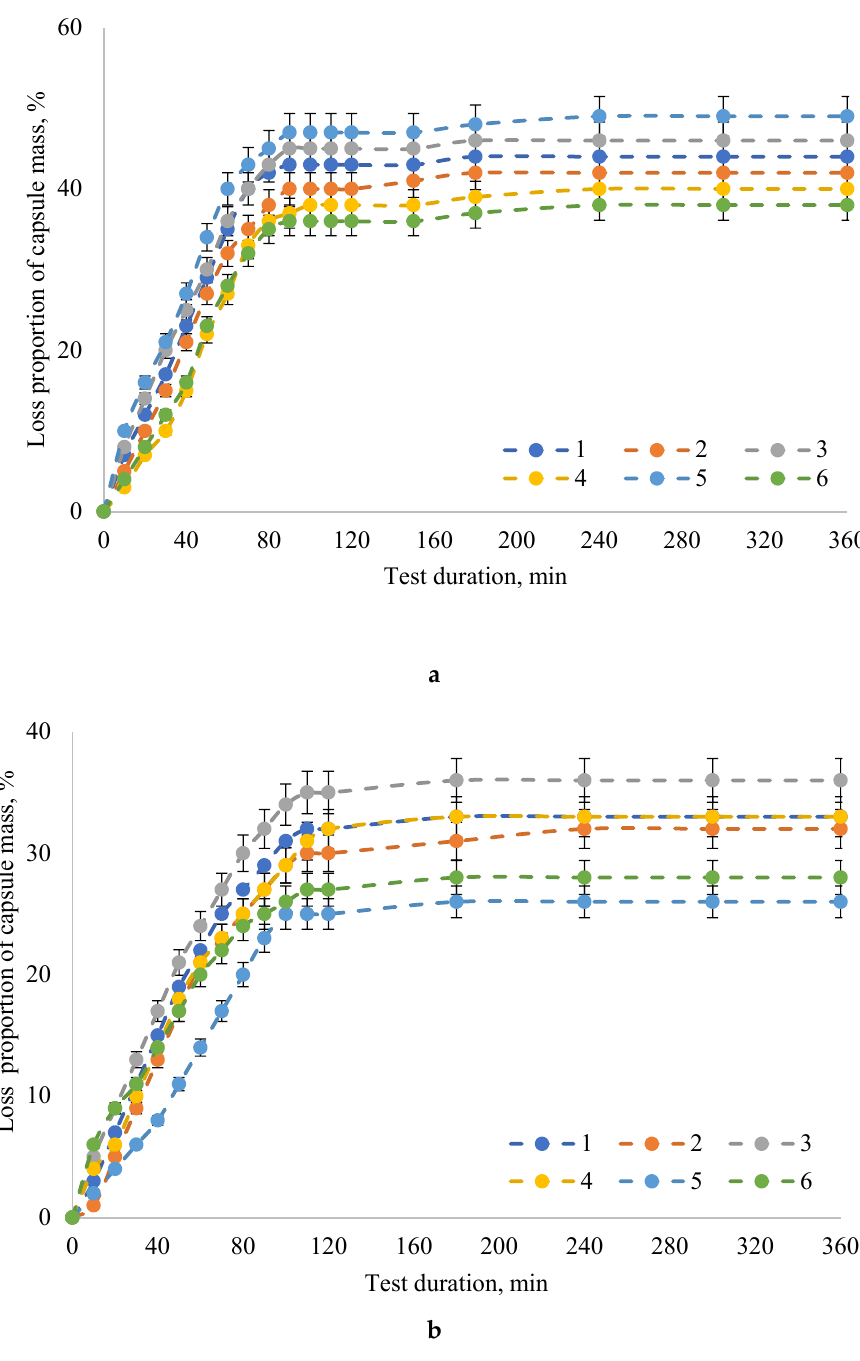
Figure 3. Dynamics of the in vitro degradation of the encapsulated form of the PAL enzyme preparation in gastric model media ( a ) SGF and ( b ) FaSSGF: 1—samples of capsules made according to the formulation No. 1; 2—samples of capsules made according to the formulation No. 2; 3—samples